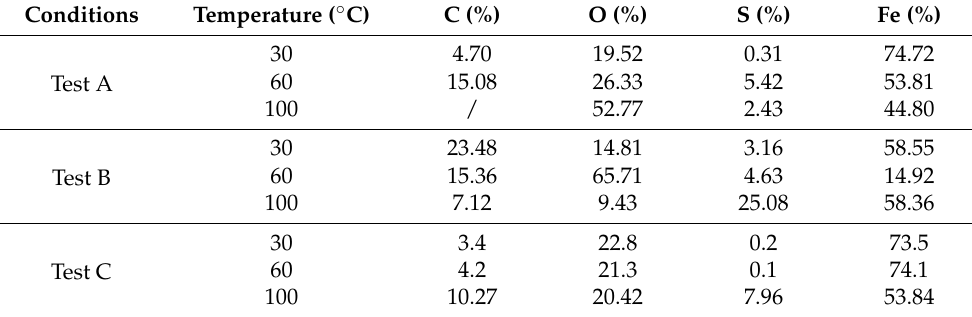
Table 6. EDS energy spectrum